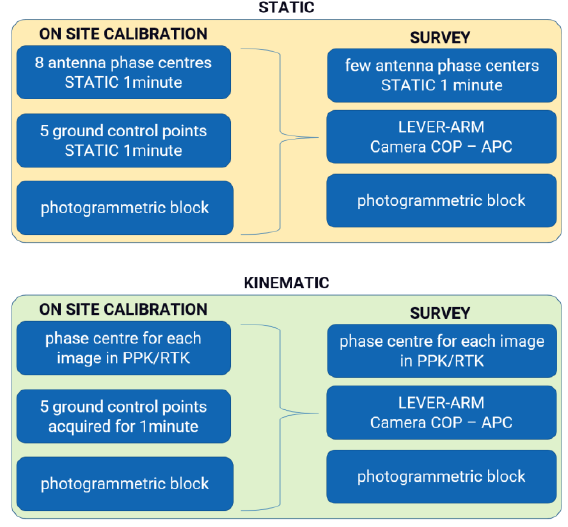
Figure 2: Static and kinematic survey approaches.